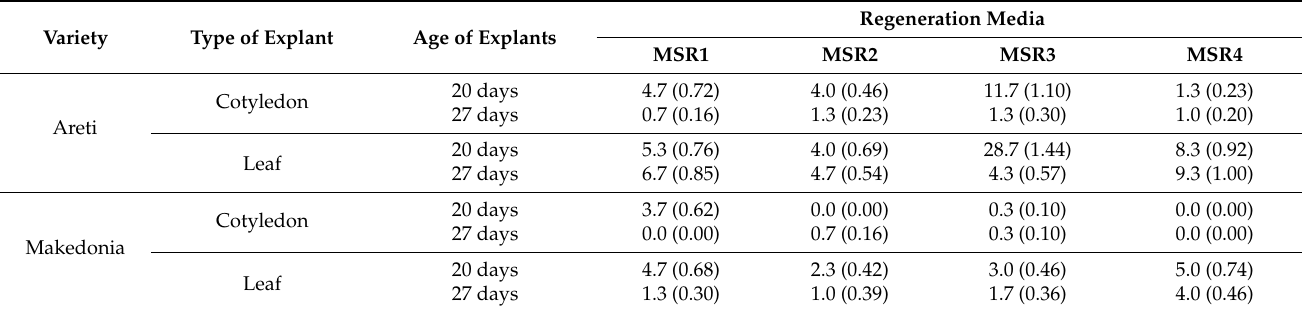
Table 2. Mean value (x) of shoot regeneration in Areti and Makedonia per explant and treatment. The regenerated shoots were derived from cotyledon and leaf explants (20 and 27 days old) in 4 media (MSR1, MSR2, MSR3, and MSR4). Numerical values outside the parentheses are the mean values of raw data, and values in the parentheses are the mean values * of log 10 -transformed data. Mean values were compared with the least significant difference